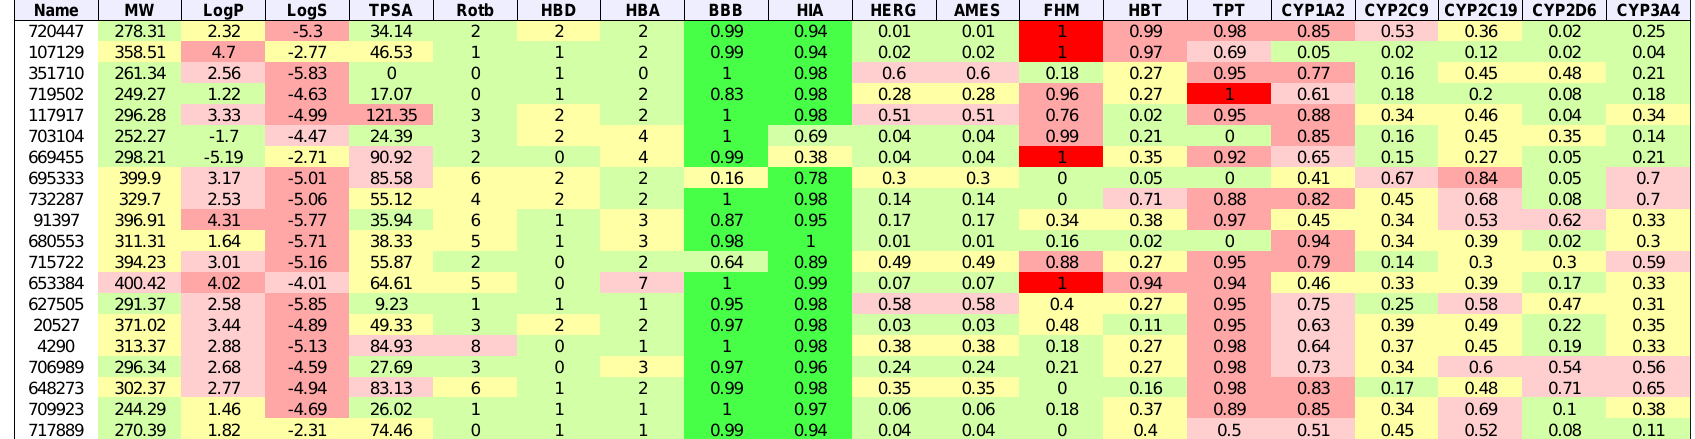
Table 5. Lung cancer: List of physio-chemical properties and predicted toxicology and ADME for top 20 ligands. Toxicology and ADME predictions are probabilities in the range [0, 1] *.